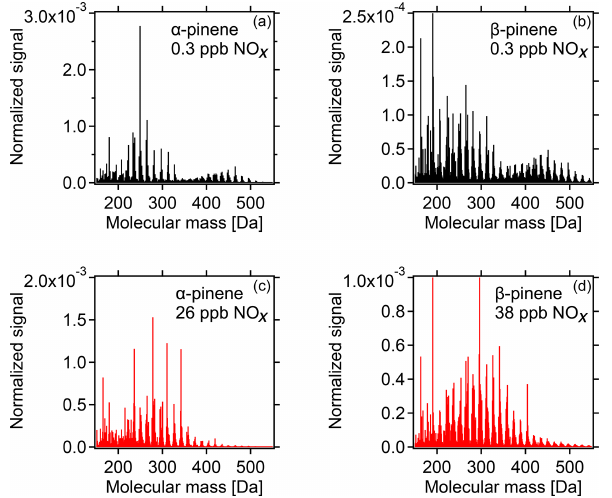
Figure 3. Mass concentration of HOM products as a function of [NO x ] SS in α -pinene photooxidation experiments. C 5 –C 20 com- pounds with molecular masses 230–550Da were added up for total HOMs (black squares) and divided into HOM monomers (light blue circles) and HOM accretion products (blue triangles). The analy- sis is based on the assigned peaks ( > 90% of the total signal) and the sensitivity of 3 . 7 × 10 10 molec.cm − 3 nc − 1 (Sect. S1.2). Dashed and dotted lines serve to guide the eye and have no further meaning. Concentrations were corrected as described in Sect. S1.2. Turnover ranged from 8 . 7 × 10 7 to 1 . 04 × 10 8 cm − 3 s − 1 , leading to correction factors in the range of 1.1–0.8. The correction factors were close to 1 and thus did not add much uncertainty. Observed particle surface ranged from ∼ 10 − 6 to 6 × 10 − 5 m 2 m − 3 , resulting in correction factors between 1.0 and 1.45, with the highest correction factors at lower [NO x ] SS where new particle formation could not be sup-